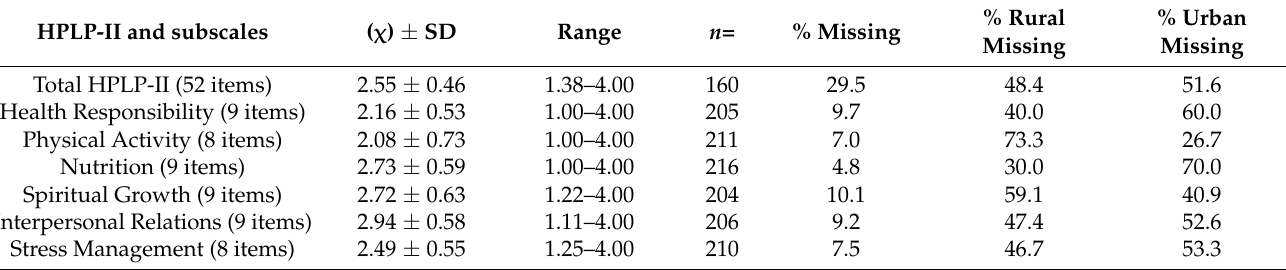
Table 1. Overall HPLP-II and subscale mean scores.